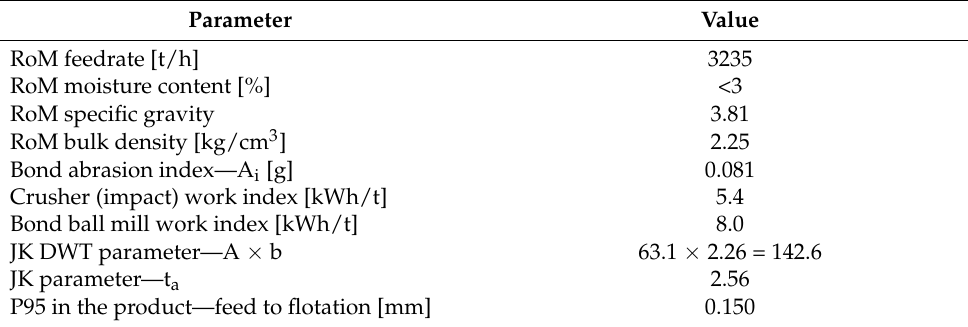
Table 1. Summary of design criteria and selected ore properties. Adapted from: [11].